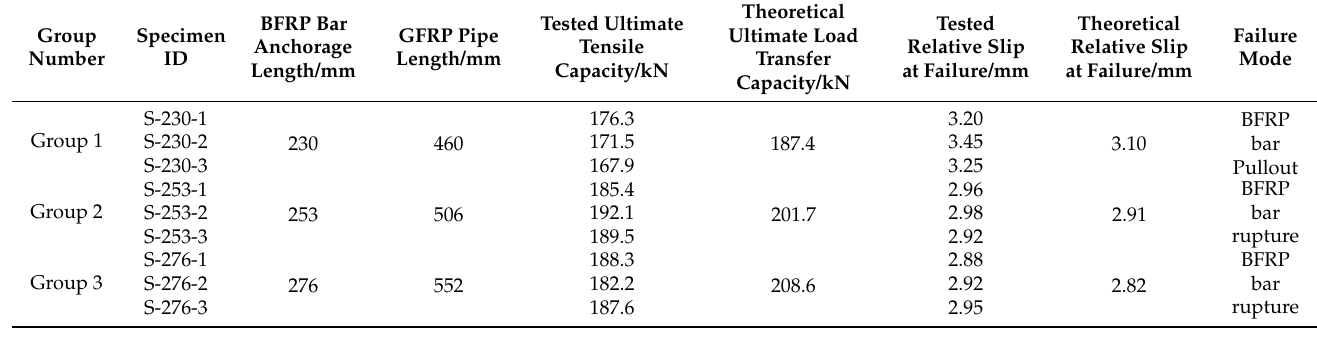
Table 2. Parameters of the bond-slip model.